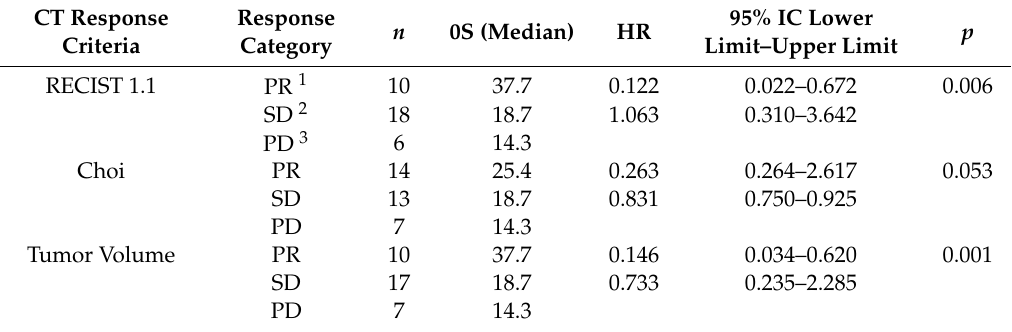
Table 3. Overall, Survival (OS) univariate analysis according to RECIST, Choi and volume staging